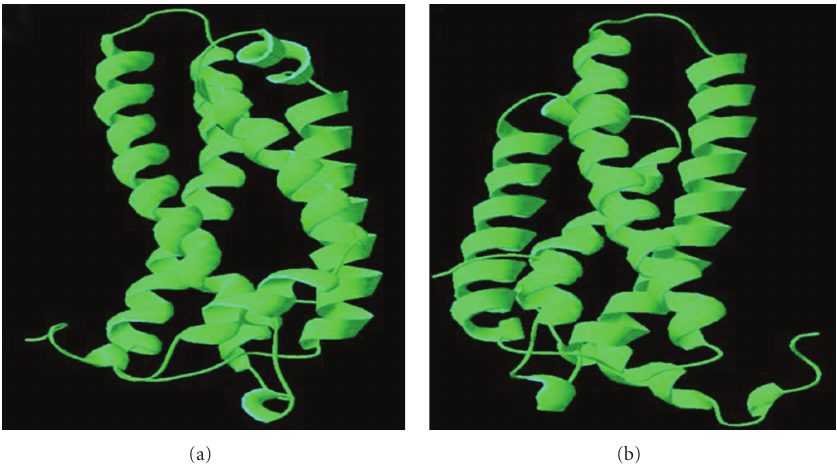
Figure 2: (a) 3D structure of template (PDB ID 2KC3), (b) homology modeled structure of APOE protein predicted using